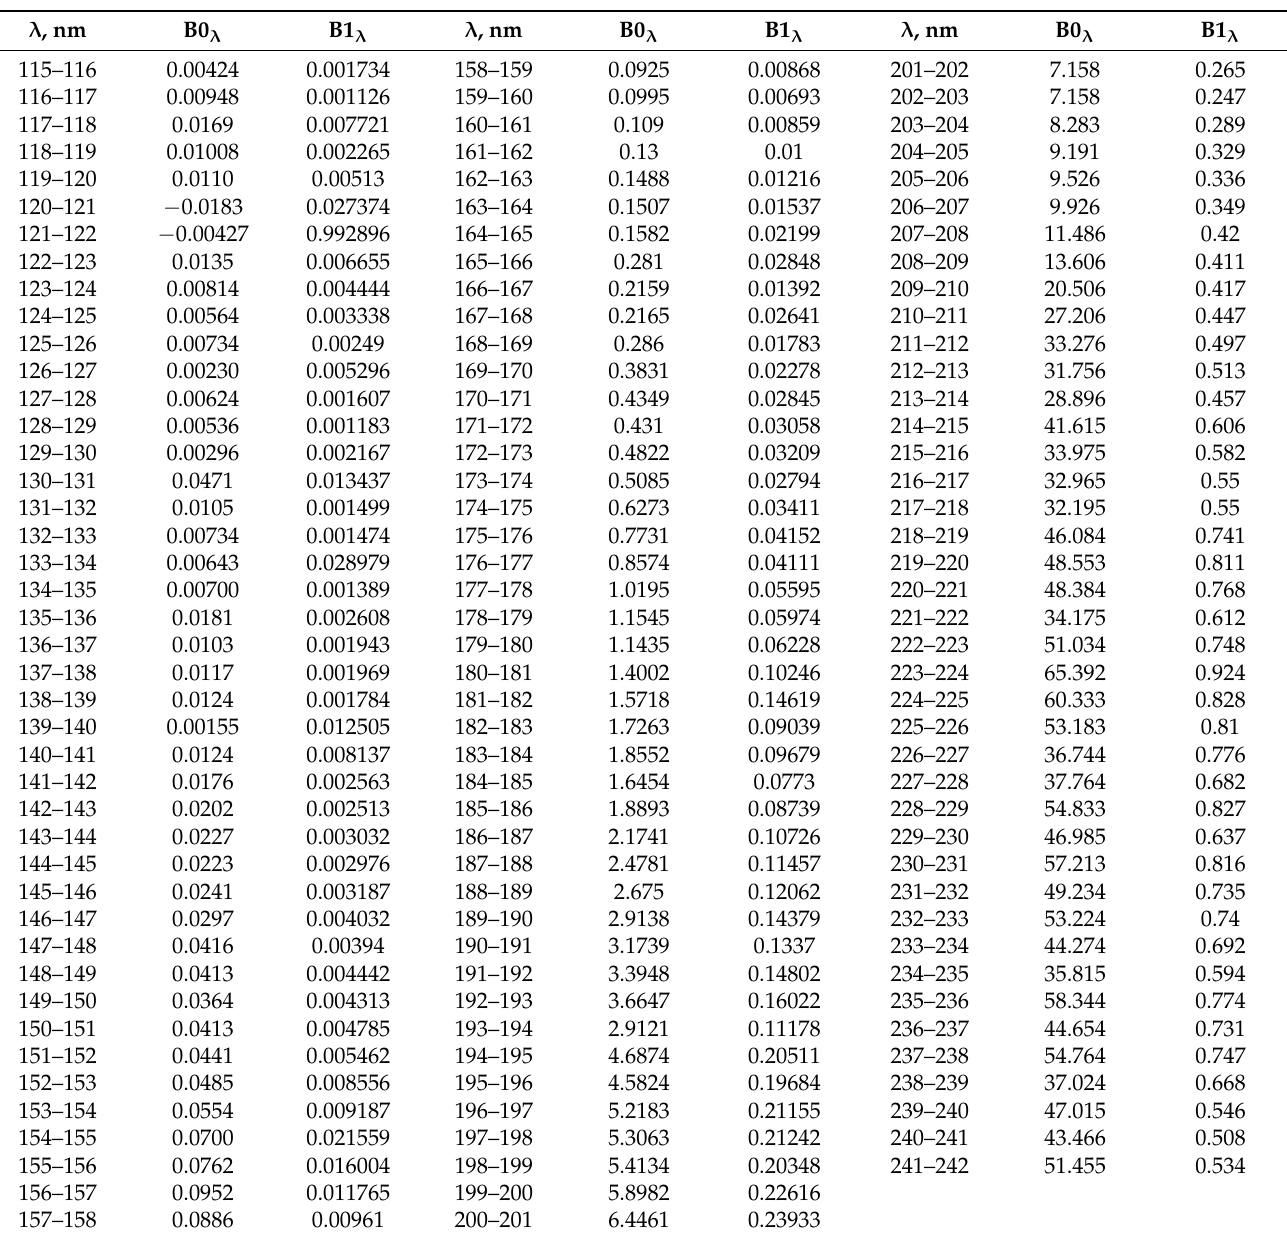
Table 2. Regression coefficients of the FUVT